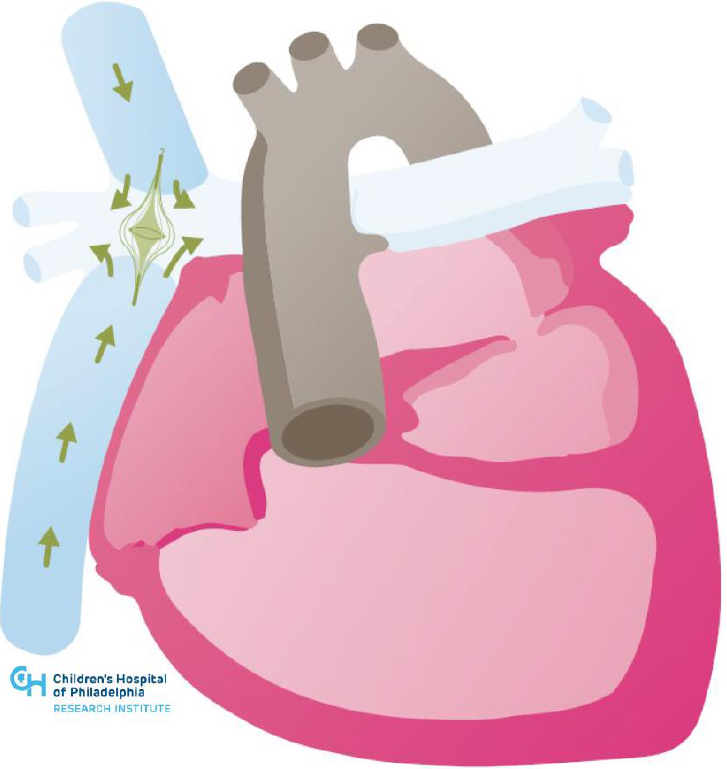
Figure 3. Illustration of cavo-pulmonary assist device in hypoplastic left heart syndrome post-Fon- tan.